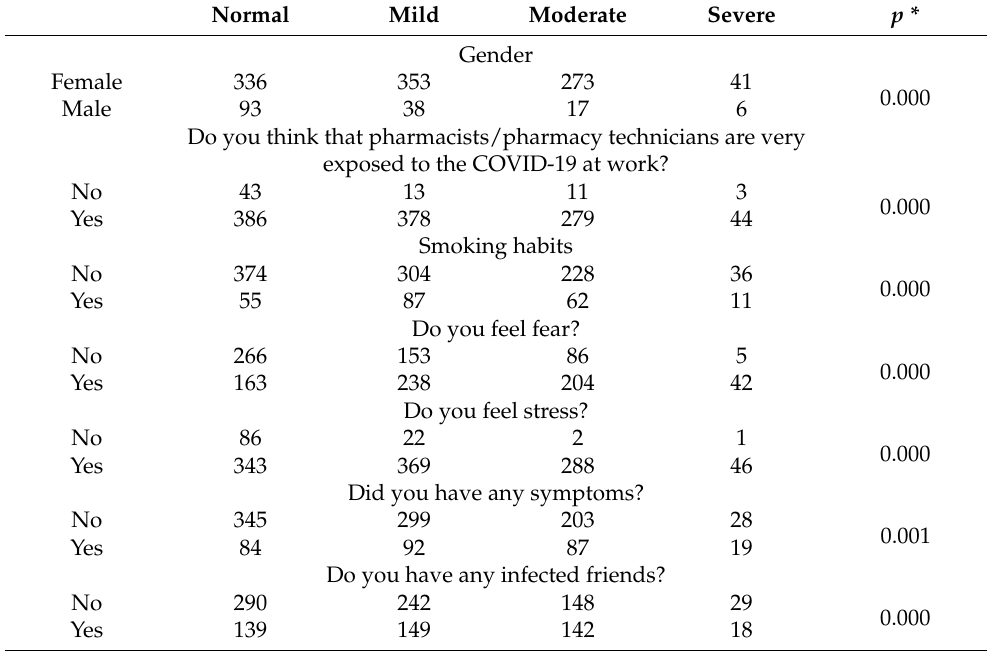
Table 3. Correlation analysis of the HADS-D levels.